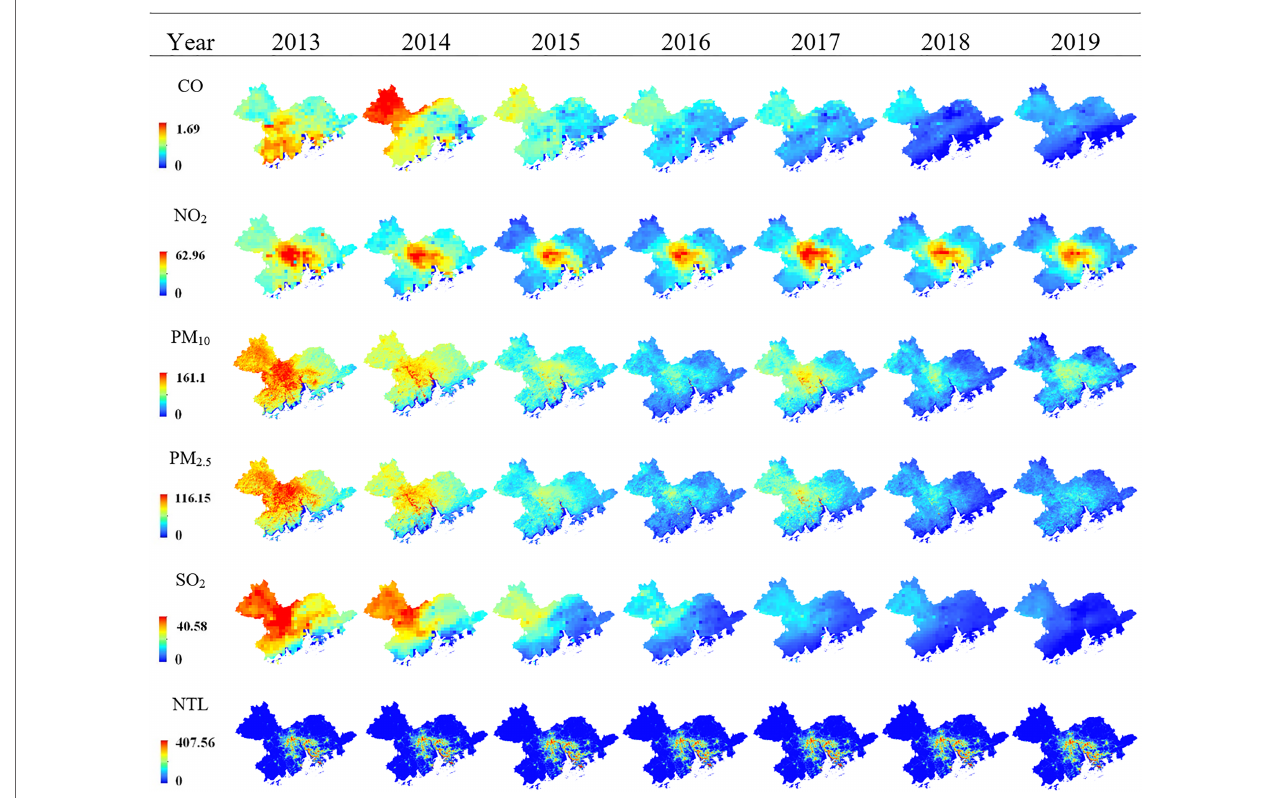
FIGURE 1 | Remote sensing data from 2013 to